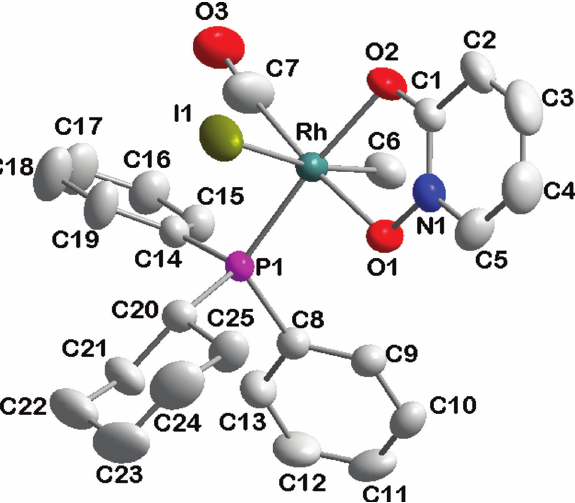
Table 1 contains crystallographic data and Table 2 contains the list of the atoms including atomic coordinates and dis- placement parameters.